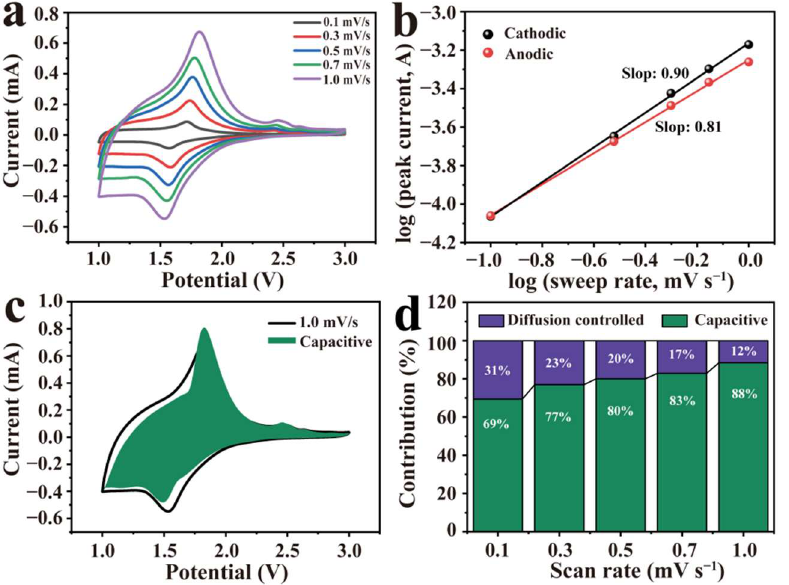
Figure 4. ( a ) CV curves and ( b ) b values of peak currents of the TNO@C at different scan rates; ( c ) capacitive contribution of TNO@C at 1.0 mV s −1 ; ( d ) capacitive contribution percentage of TNO@C.